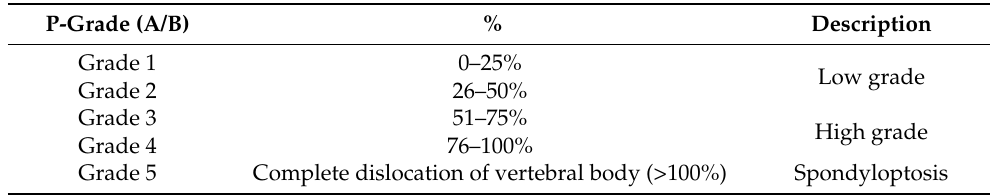
Table 1. Classification of the vertebral slippage